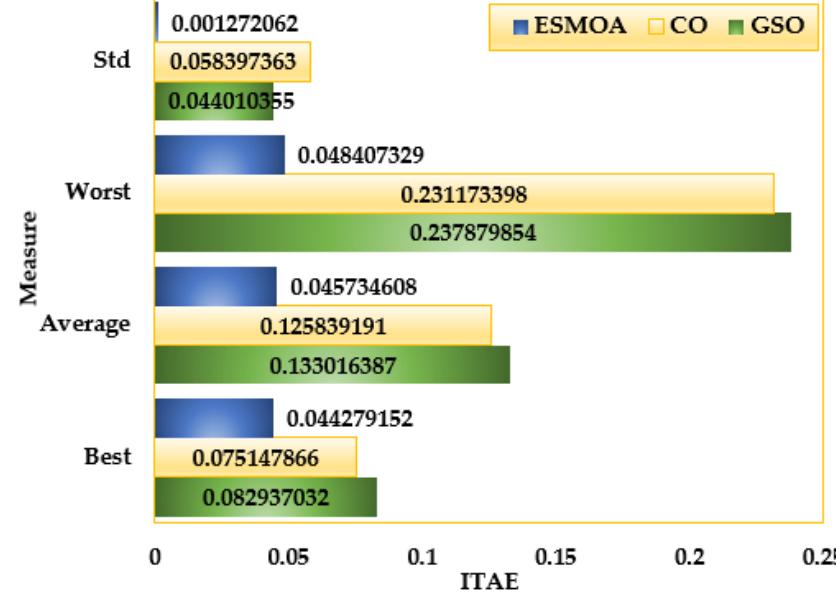
Figure 13. Statistical measures for CO, GSO, and the proposed ESMOA for Case 3. Table 8 contrasts the efficacy of the proposed ESMOA-based PD-PI controller with various previously published controlling methods concerning ITAE. As shown, the pro- posed ESMOA-based PD-PI controller obtains the minimum ITAE of 0.04428, where the conventional PID-based-PSO, PID-based-ARA, PID-based-JAYA, PI-based-DE, PID-based- SAMPE-JAYA, CO-based PD-PI controller, and GSO-based PD-PI controller find 0.2354, 0.146308, 0.2272, 0.2021, 0.1726, 0.075148, and 0.082937, respectively. Table 8. Comparison of the proposed ESMOA outcomes with other reported results in terms of ITAE for Case 3.